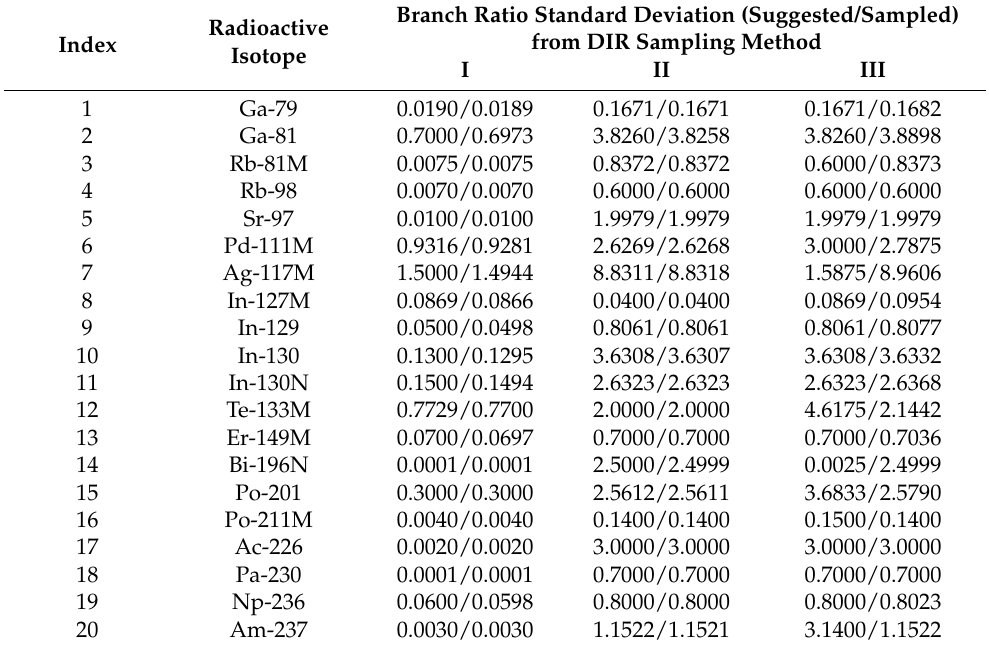
Table A4. DIR sampling: branch ratio standard deviation estimation results.